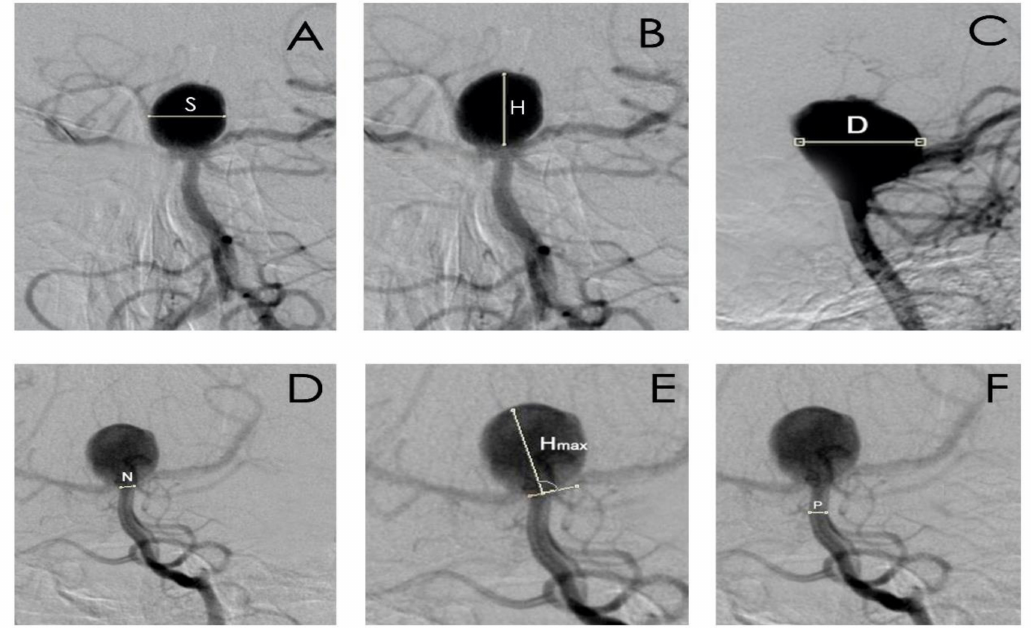
Figure 1. The morphometric parameters: ( A ). S—the aneurysm dome width size, ( B ). H—the aneurysm dome height size, ( C ). D—the aneurysm dome depth size, ( D ). N—aneurysm neck size, ( E ). H max —maximal perpendicular height, the largest perpendicular distance from the neck of the aneurysm to the dome of the aneurysm, ( F ). P—parent artery